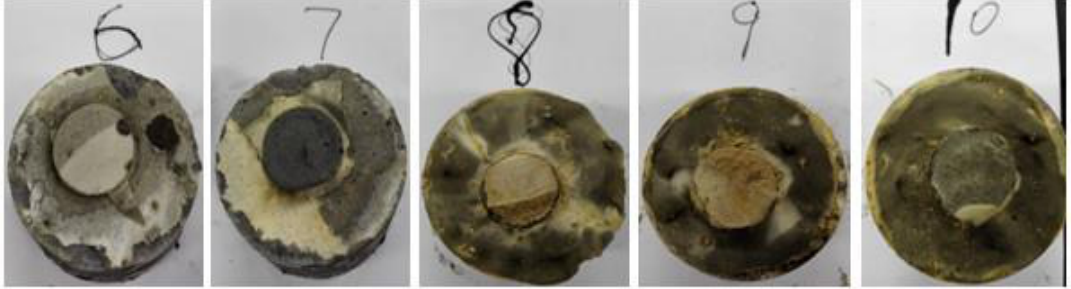
Figure 14. Maintenance figure of core sample after flushing (48 h × 80 °C).